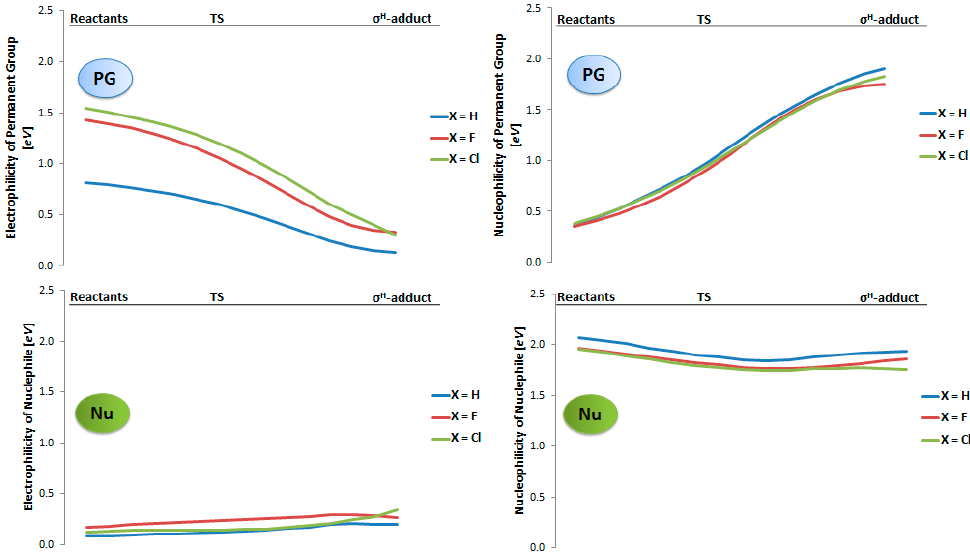
Figure 6. Changes of electrophilicity for permanent group ( upper left ), nucleophile ( lower left ) and nucleophilicity for permanent group ( upper right ) and nucleophile ( lower right ) during the nucleophilic substitution in the ortho position.